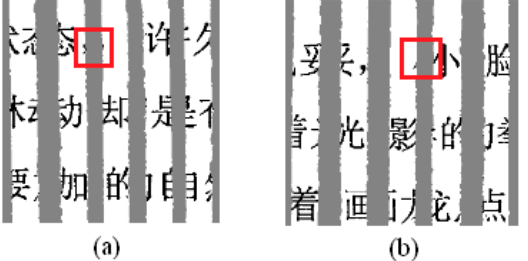
Figure 22. Examples of a small part of a word or a punctuation mark in a shred. ( a ) a small part of a punctuation mark in a shred; ( b ) a small part of a word in a shred.